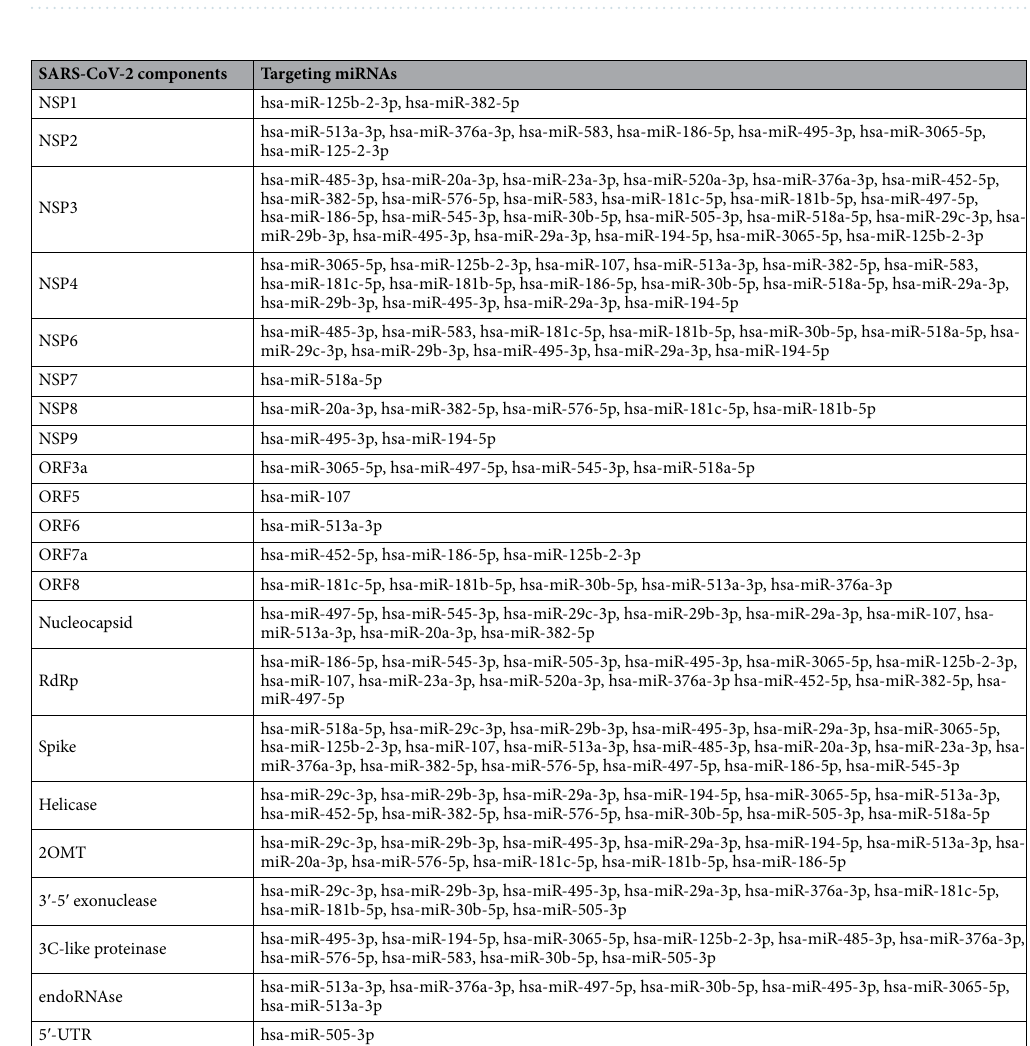
Table 4. SARS-CoV-2 components can be targeted by enoxacin-induced miRNAs.